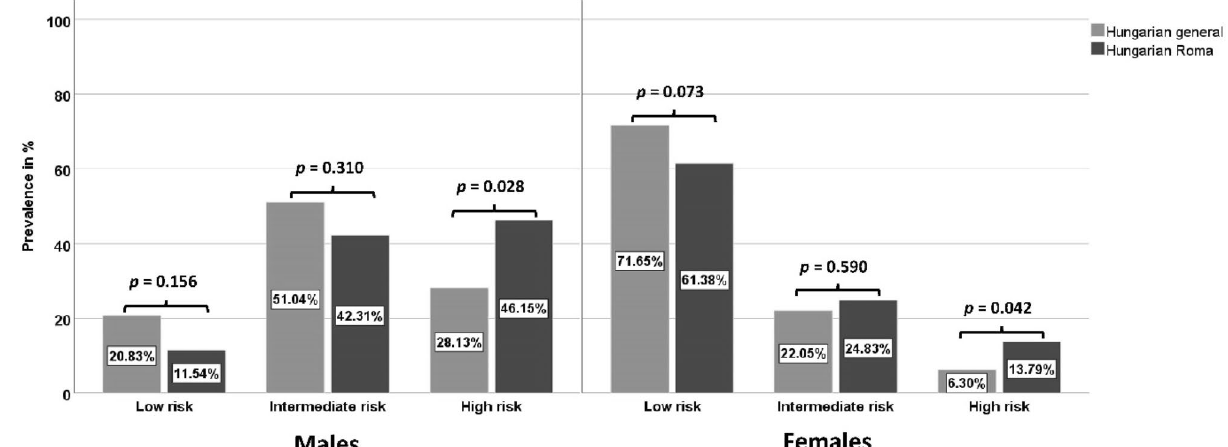
Figure 3. Distribution of SCORE risk categories in the 40–64-year-old Hungarian general and Hungarian Roma populations.